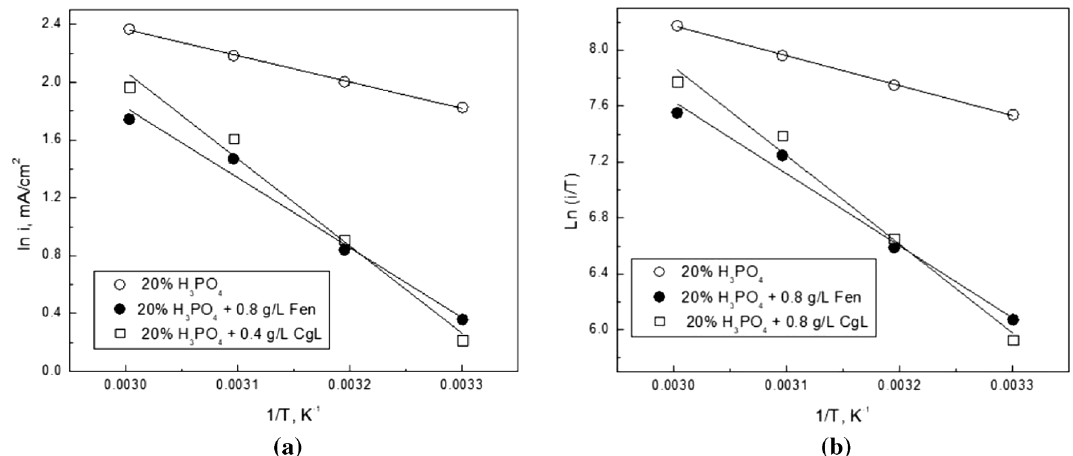
Figure 10. Variation of ( a ) lni and ( b ) ln i/ T vs 1/T for steel in 20% phosphoric acid in the absence and presence of 0.8 g/L Fen and 0.4 g/L CgL extract.